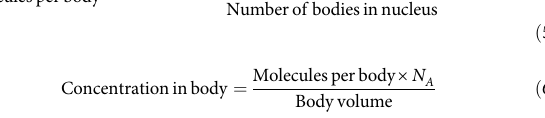
tool 69 . Brie fl y, Spot-On determines the fractions of and diffusion coef fi cients of tracked molecules in different states using a two- or three-state kinetic model. Spot- On models the distributions of measured displacements from tracks, accounting for localisation error and correcting for bias due to movement of diffusing mole- cules out of focus. The probability of molecules diffusing out of focus is calculated and losses of diffusing molecules used to infer the fractions and diffusion coef fi - cients for the model states. Jump length distributions were generated using a bin width of 0.01µm with 8 time points and 4 jumps permitting a maximum jump length of 5.05 µm. Jump length distributions were fi tted with a three-state kinetic model with a localisation error of 40nm, using Z correction with dZ = 0.7 and cumulative density function fi tting with three iterations. Tracks from individual movies, each containing multiple cells, were fi tted separately. All statistical analyses were performed on individual movie fi ts. Bound fractions and estimated numbers of bound proteins for PRC1 subunits are given in Supplementary Table 4. Single molecule binding time analysis . Tracking movies for measuring single molecule binding times were localised and tracked as described above, using a tracking radius of 192 nm for 2Hz imaging or 672 nm for 0.03 Hz imaging. These limits were determined based on the measured displacements of stably bound H2B- HaloTag molecules due to chromatin diffusion. Track lengths of stationary molecules were used to determine apparent dwell times of chromatin bound molecules. Mean survival times were determined by fi tting the observed distribu- tion of apparent dwell times with a double exponential function: